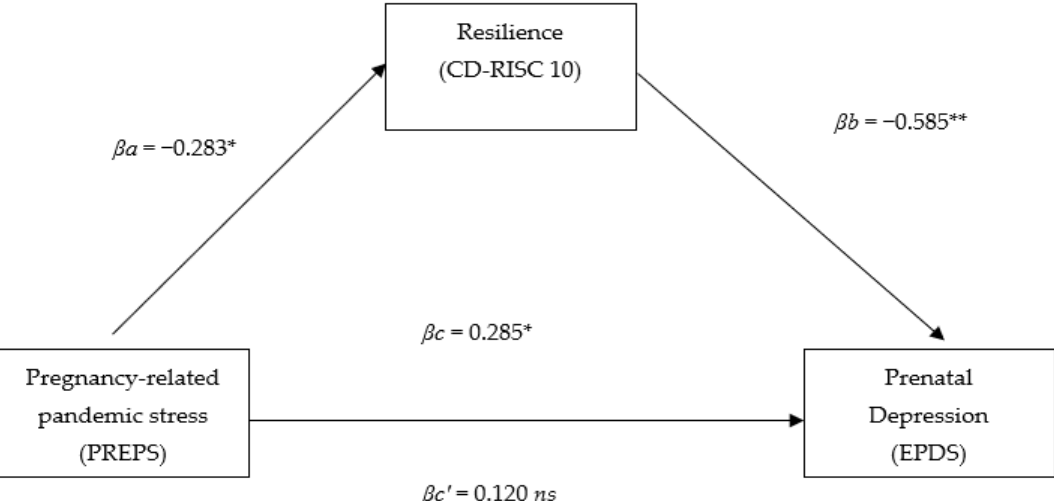
0.001) and between resilience and prenatal depression ( β b = − 0.491, SE = 0.08, t = − 4.39, p <